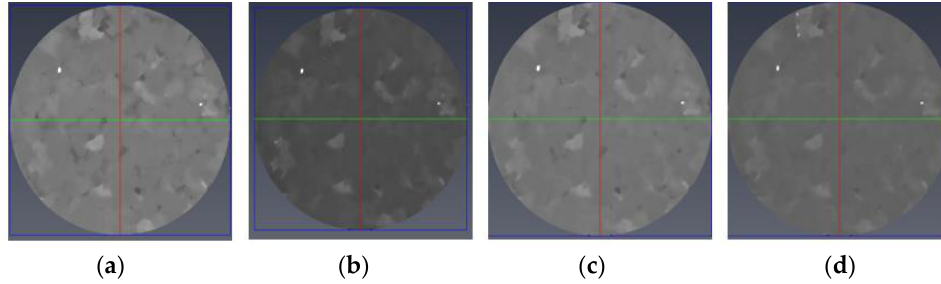
Figure 9. CT scanning images under different displacement states in rock samples. ( a ) Dry rock sample. ( b ) Saturated crude oil. ( c ) CO 2 flooding. ( d ) Water flooding.